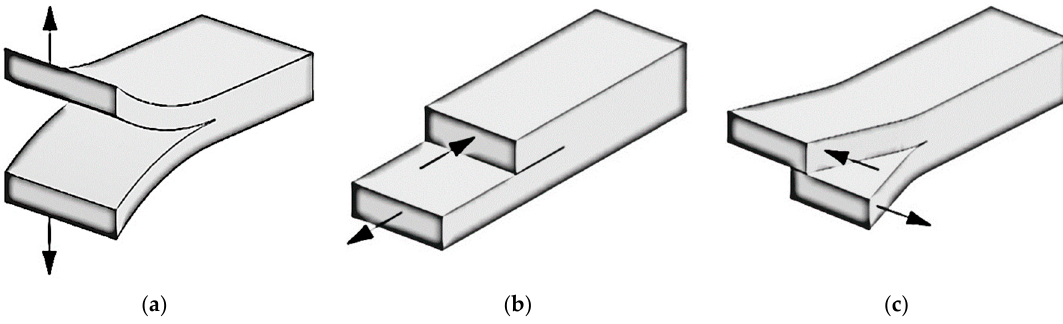
Figure 3. Modes of fracture: ( a ) Mode-I (opening); ( b ) Mode-II (sliding); ( c ) Mode-III (tearing) [42].